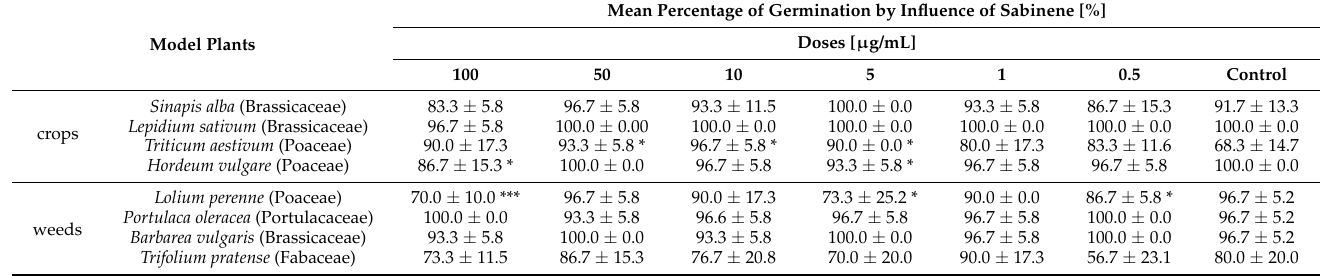
Table 4. Percentage (%) of germinated seeds after 120 h from the application of several doses of sabinene. Results are reported as the mean ± SD of six